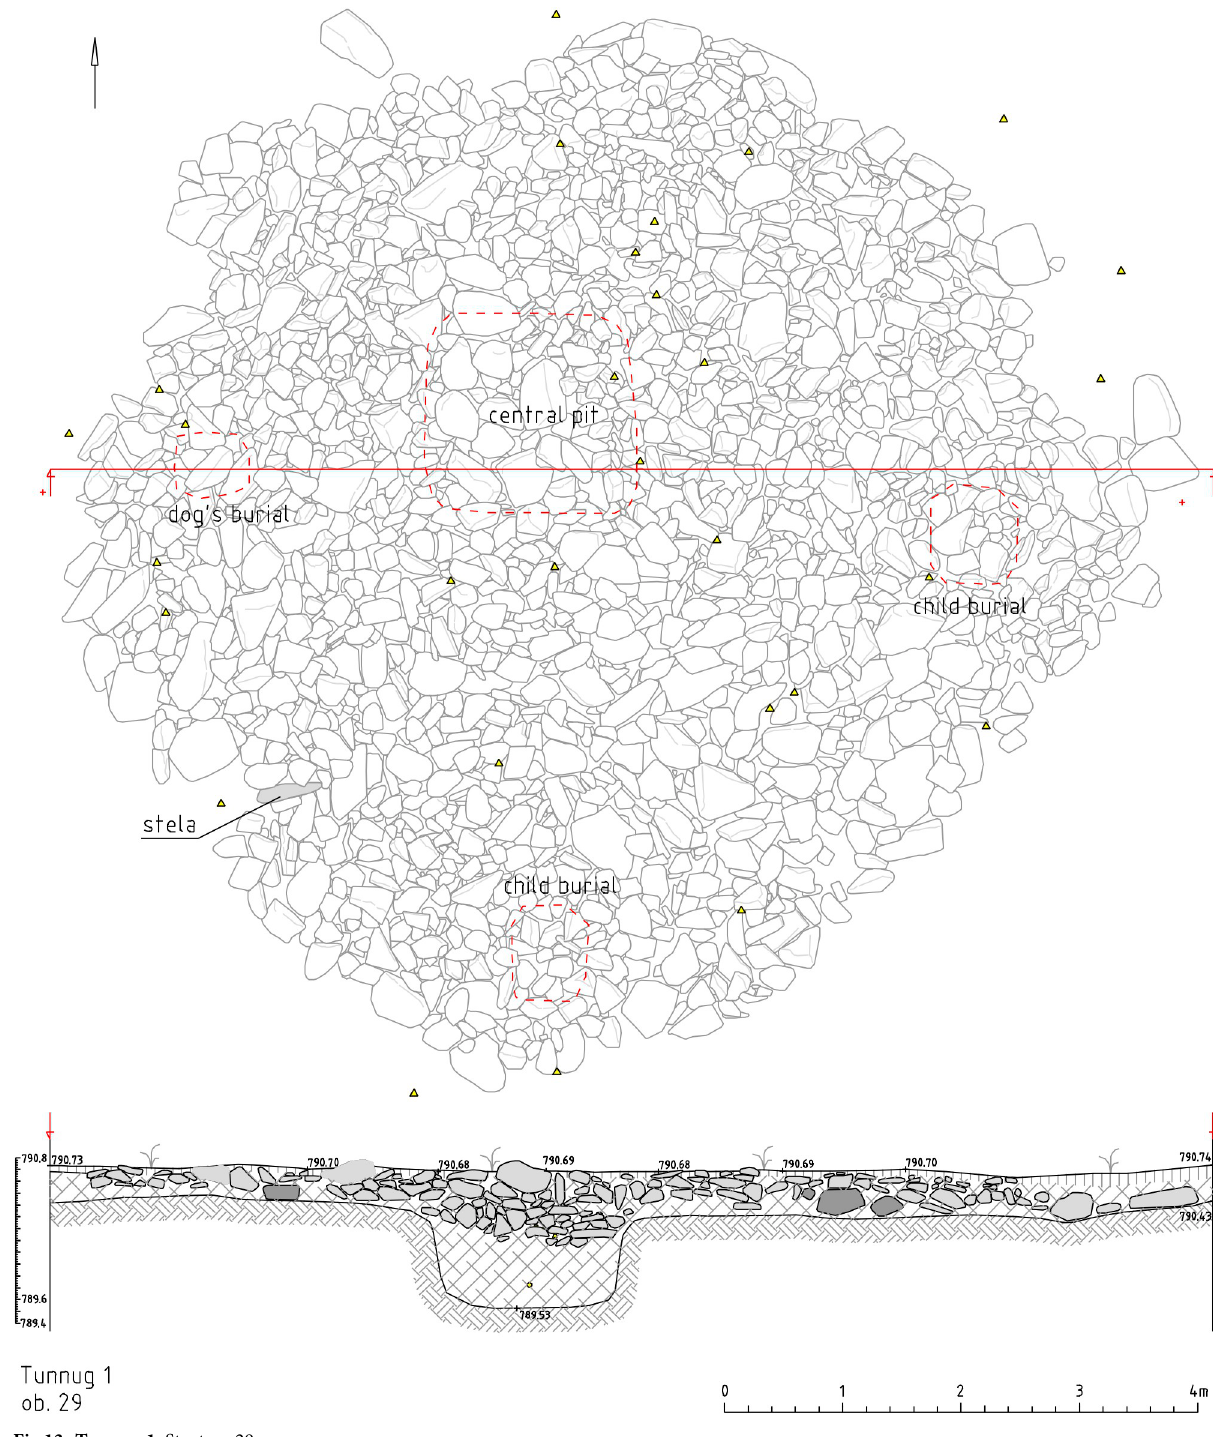
Fig 13. Tunnug 1. Struture 29.